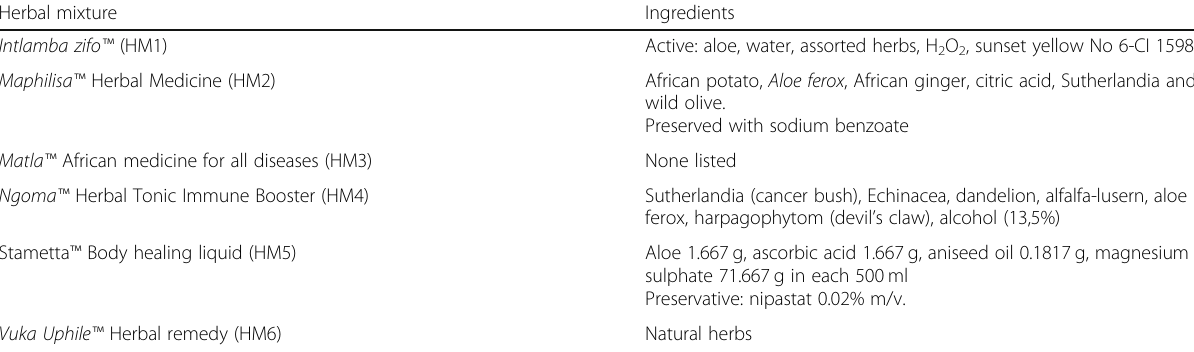
Table 1 The components of each herbal medicine as listed on the package or label Herbal mixture Ingredients